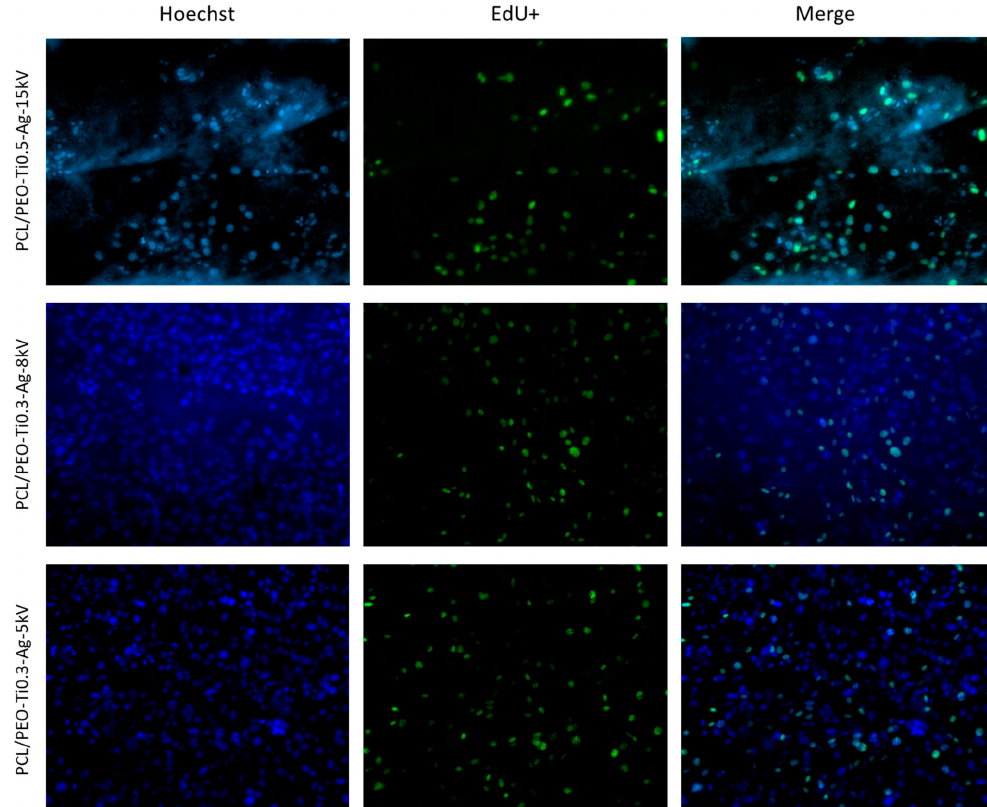
Figure 3. Human mesenchymal cells on the surface of PCL/PEO-Ti0.5-Ag-15 kV, PCL/PEO-Ti0.3-Ag-8 kV and PCL/PEO-Ti0.3-Ag-5 kV nanofibers mats after three days of cultivation. The cell nuclei were stained by Hoechst 33,342 (blue), nuclei of proliferating cells were stained by The Click-iT EdU Alexa Fluor 488 Imaging Kit.